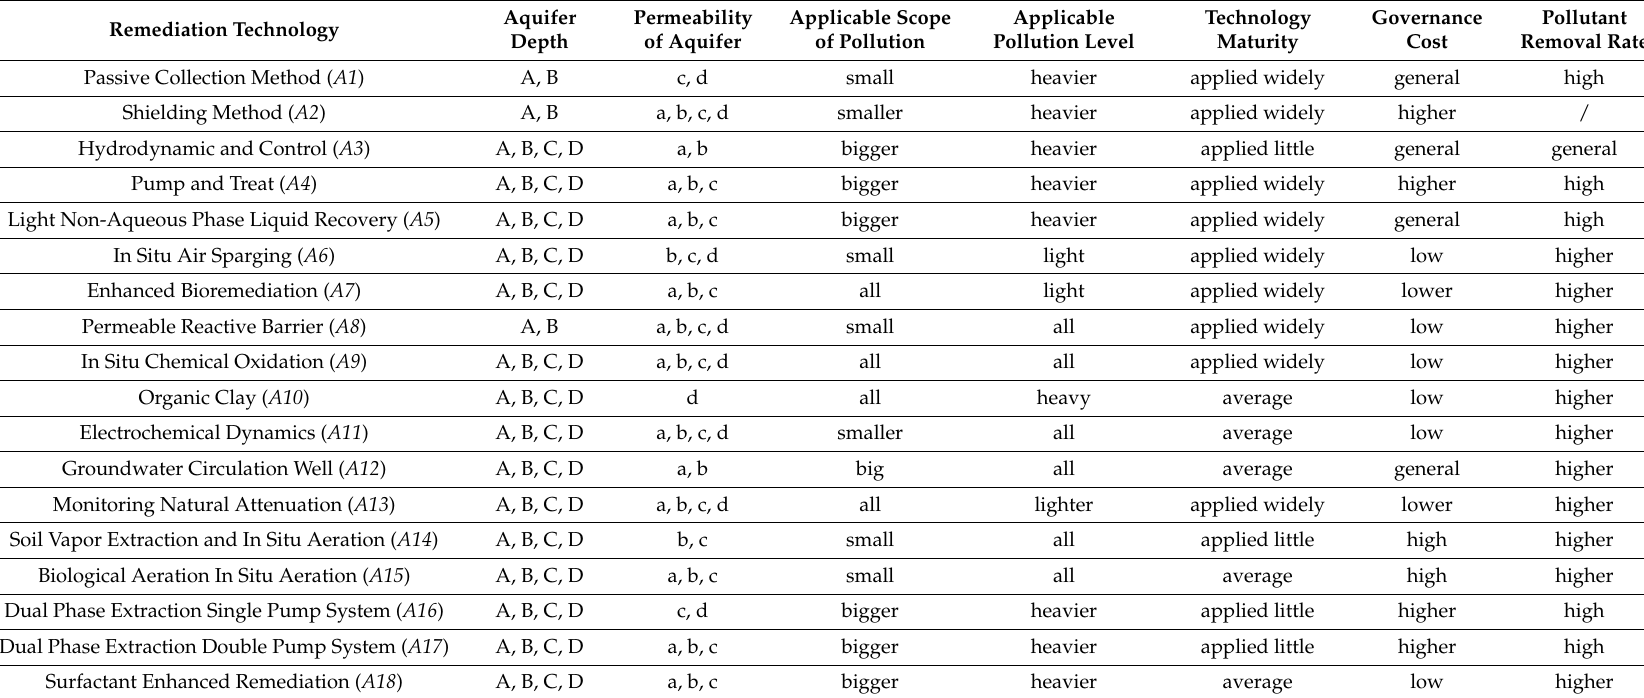
Table 5. The description of indicators in natural language. (Aquifer depth: A—4.6 m; B—4.6~15.2 m; C—15.2~30.5 m; D—>30.5 m. Permeability of aquifer: a—better; b—good; c—bad;